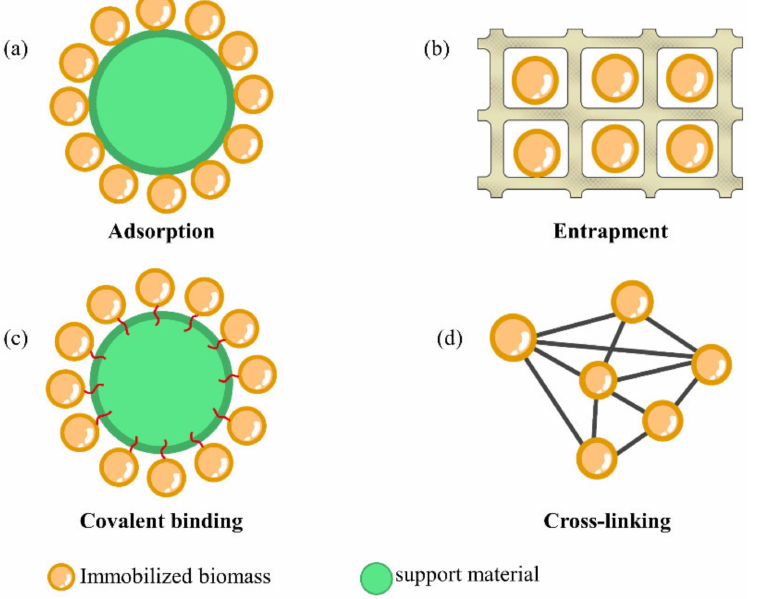
Figure 1. Illustrative scheme showing immobilization methods: ( a ) adsorption, ( b ) entrapment, ( c ) covalent binding, ( d )